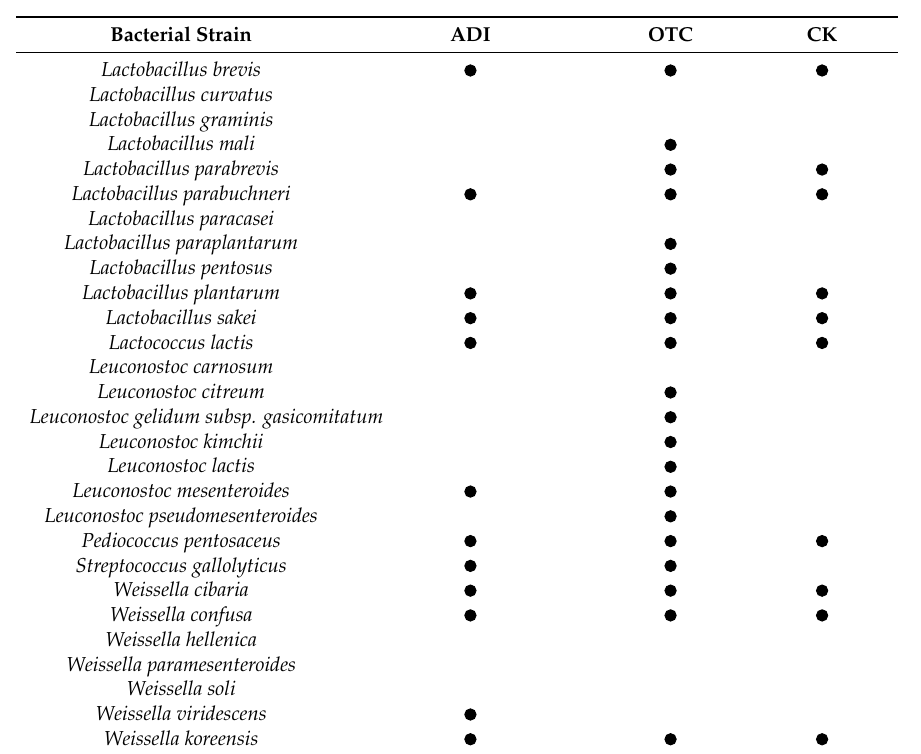
Table 2. Summary of the ADI systems present in various lactic acid bacteria.